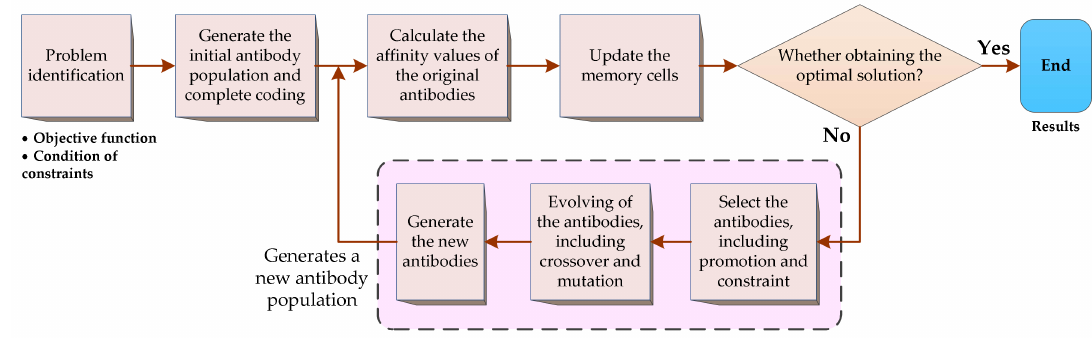
Figure 9. The basic flow chart of